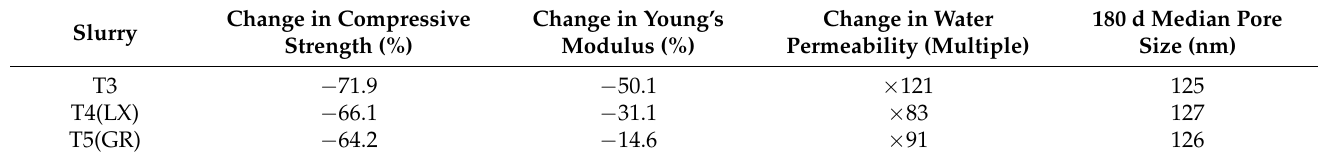
Table 2. Variation of test properties from 2 to 180 d and median pore size of 180 d sample (50 MPa).